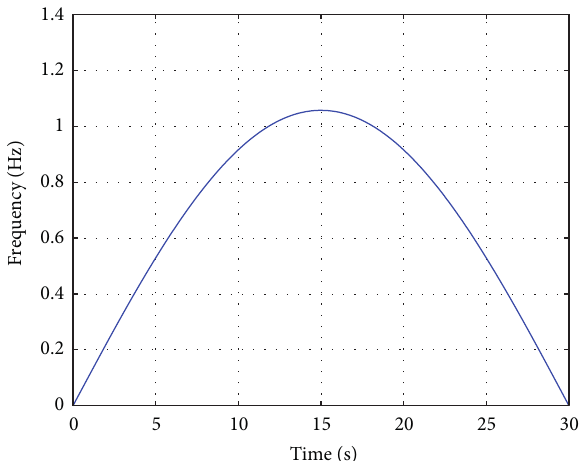
Figure 11: The Doppler frequency difference between Path I and Path II in the earth curvature model.